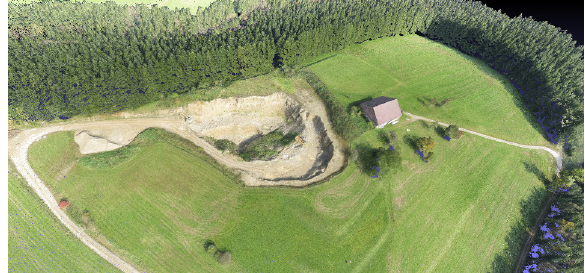
Figure 5: Colored model of a gravel pit with surroundings.